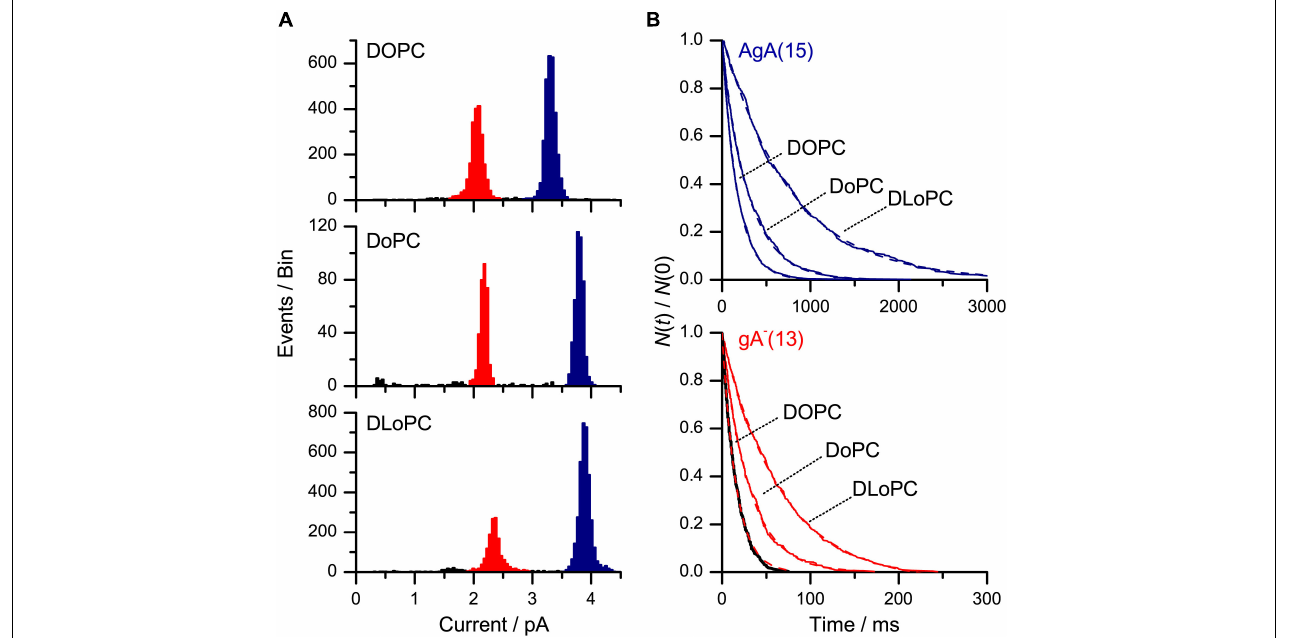
FIGURE 9 | Effects of changes in bilayer composition on AgA(15) and gA − (13) channel function. (A) Current transition amplitude histograms obtained in (from top to bottom): DOPC/ n -decane, DoPC/ n -decane and DLoPC/ n -decane bilayers. The lower amplitude peaks, highlighted in red, denote gA − (13) channels; the higher amplitude peaks, highlighted in blue, the AgA(15) channels. (B) The corresponding normalized single-channel duration histograms. Results from single experiments fitted by single exponential distributions (the colors have same significance as in A ). The lifetime results are summarized in Table 3 . 1 M NaCl, pH 7, 200 mV, 500 Hz.